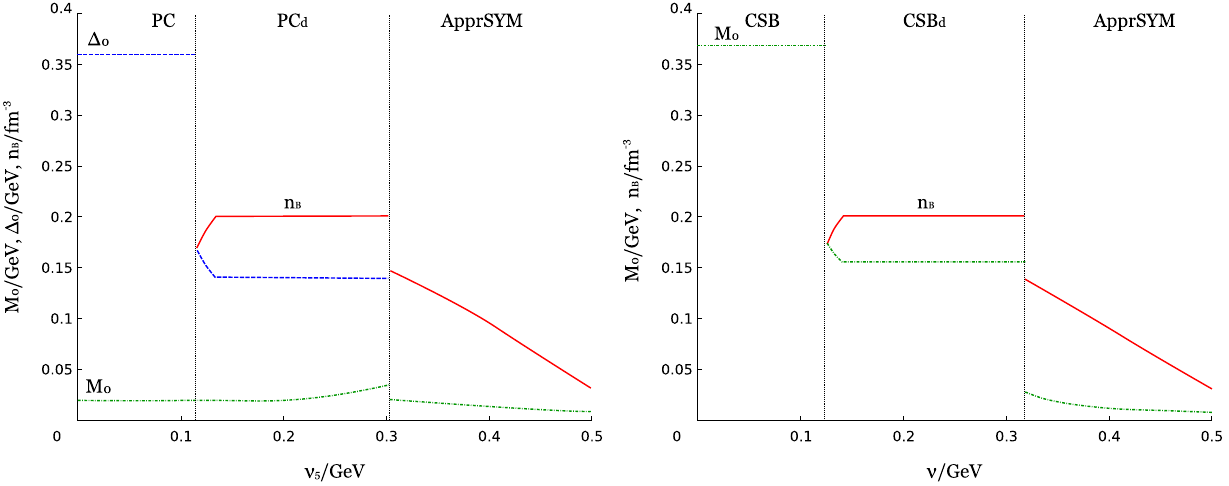
Fig. 5 The Gaps M 0 ,(cid:13) 0 and baryon density n B vs. ν 5 at μ = 200MeV and ν = 350 MeV (left panel). The same quantities M 0 ,(cid:13) 0 and n B vs ν at μ = 200MeV and ν 5 = 350 MeV (right